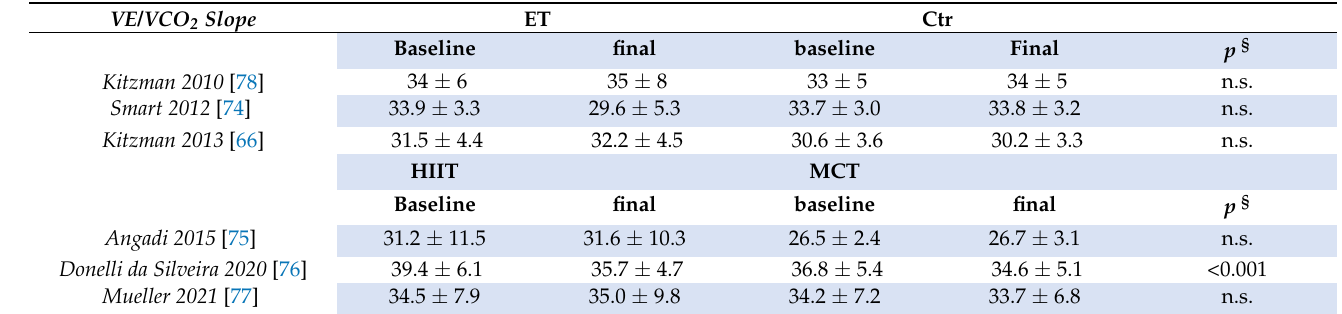
Table 2. Results of trials investigating the effects on minute ventilation/carbon dioxide production (VE/VCO 2 ) slope of exercise training in HFpEF.